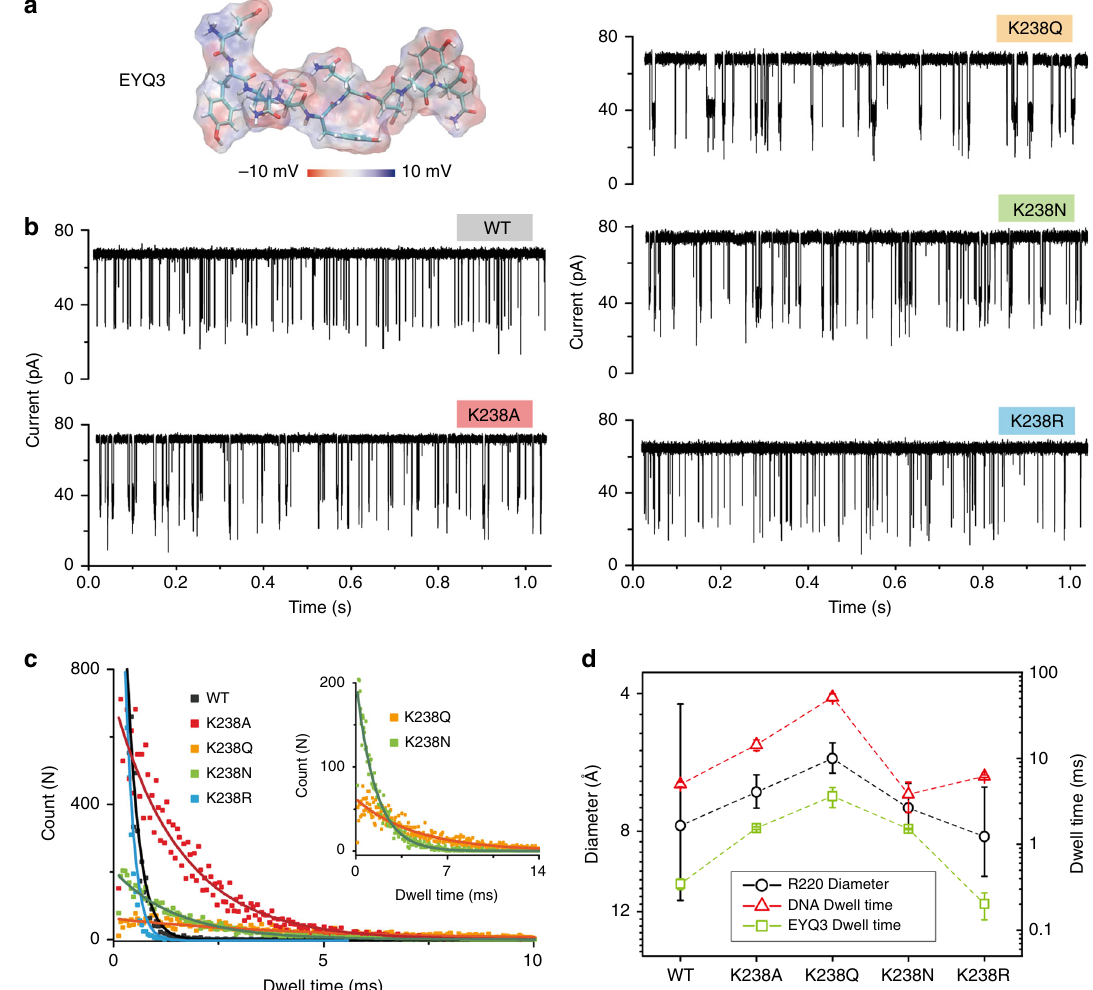
Fig. 4 Negatively charged peptide sensing by aerolysin engineered pores. a 3D structure of EYQ3 with its electrostatic potential mapped on the peptide molecular surface. b Raw single-channel recording traces upon EYQ3 addition into the cis chamber of wt, K238A, K238Q, K238N, and K238R mutants, respectively. The fi nal concentration of EYQ3 in the chamber was 2 μ M. c Dwell time distribution of EYQ3 translocating through the wt (black), K238A (red), K238Q (orange), K238N (green), and K238R (blue) protein pores under + 100 mV voltage. d Comparison between dwell time of EYQ3 (green squares), dwell time of DNA (red triangles), and the diameter at R220 region (black circles) for wt and pore